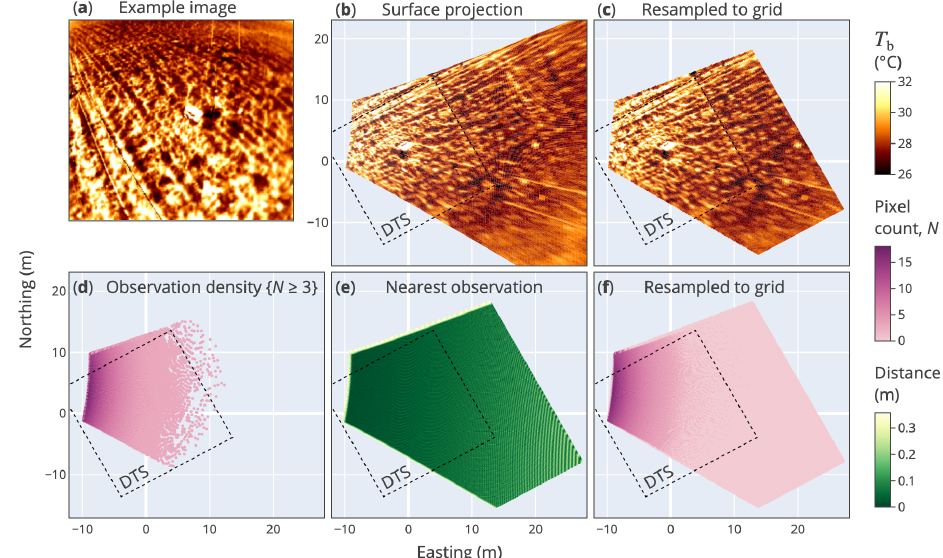
Figure A5. The (a, b) thermal image data were (c, f) spatially resampled in a regular grid of 0 . 25 × 0 . 25m, matching the orientation of the fibre-optic array (DTS). At least (d) three observations should fall within a grid cell, or else (e) the nearest value within a 0 . 35m radius was used for computation.